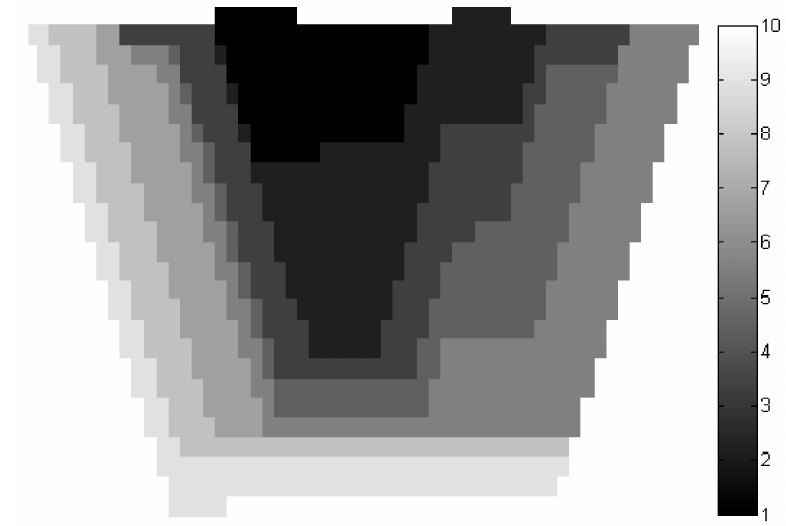
Figure 8. East–West section of the production schedule of the study mine using the proposed method with deterministic orebody model (color bar represents production period in year).